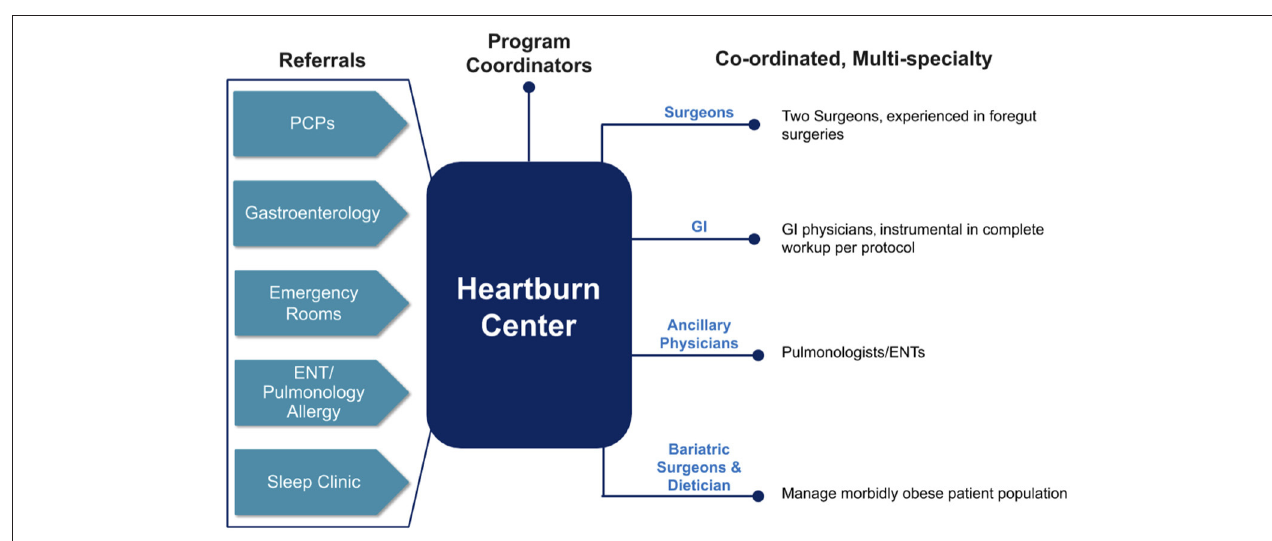
FIGURE 2 | Organizational structure of the practice model for our heartburn center of excellence.